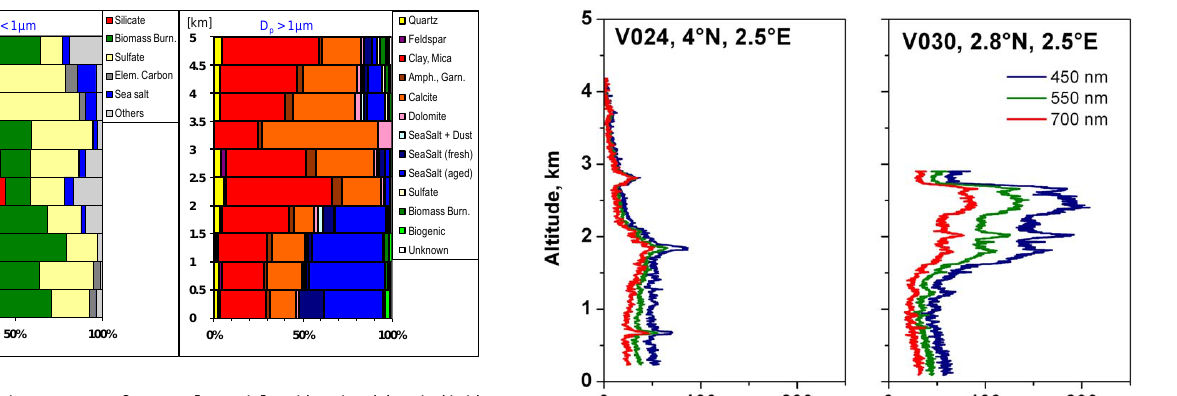
Fig. 12. Various types of aerosol particles identified by individ- ual particle analysis in the submicron and supermicron sizes, and their relative abundance averaged over all ATR-42 flights during SOP2a2. Fig. 13. Vertical profiles of the aerosol scattering coefficient mea- sured during flights V024 of SOP 1a1 and V030 of SOP 2a1 at 450 (blue line), 550 (green line), and 700nm (red line) by the ATR-42.